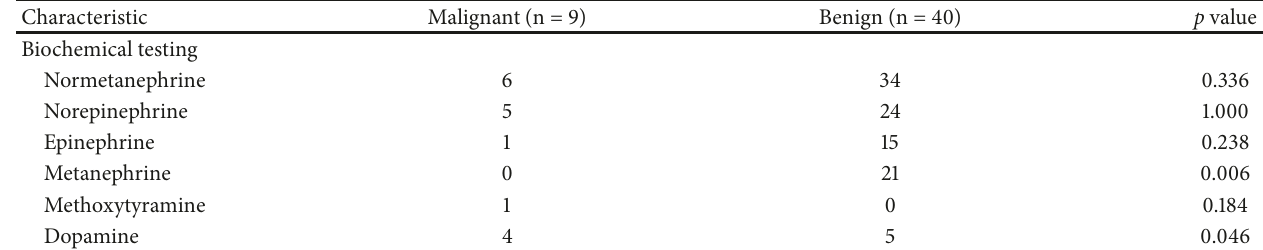
Table 2: Catecholamine secretion by malignant and benign PC/PG cases derived from TCGA.